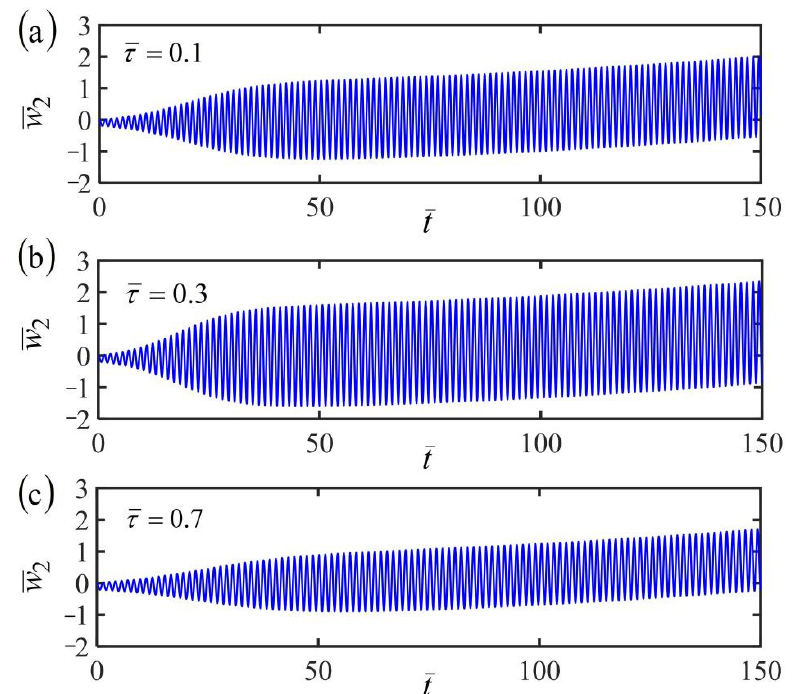
Figure 12. Time histories of the displacement of the fiber-mass system with uniformly accelerated translational frame in a linear temperature field for ( a ) finite characteristic times τ = 0.1, ( b ) τ = 0.3, and ( c ) τ = 0.7. The amplitude first increases and then decreases obviously with the increasing characteristic